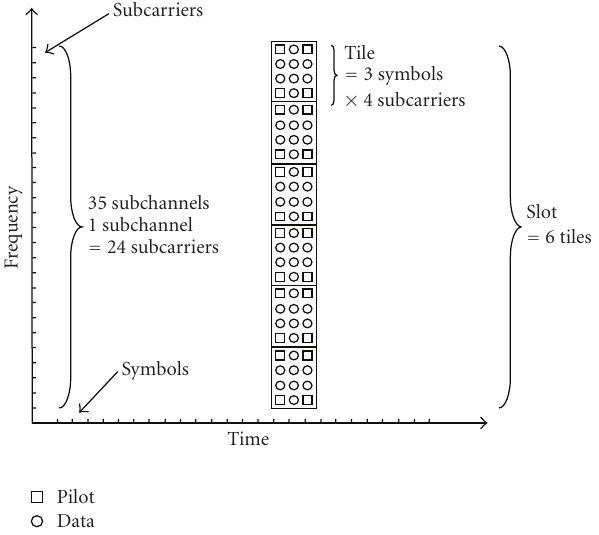
Figure 2: Symbols, tiles, and slots in uplink PUSC.